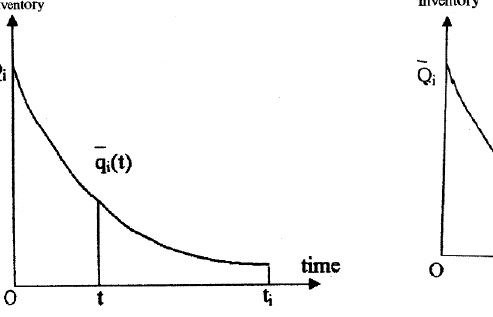
Figure 5. Inventory ends with stock. Figure 6. Inventory ends with short-